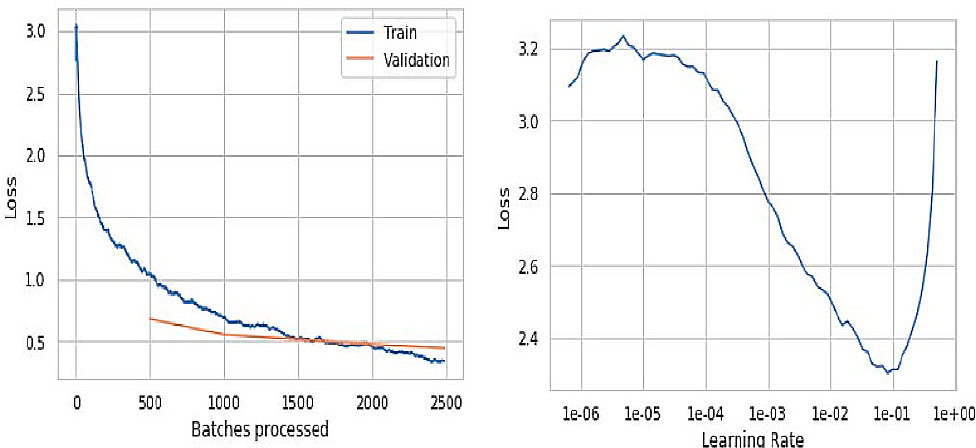
Figure 6. Resultant outcomes post optimizing the training rate.